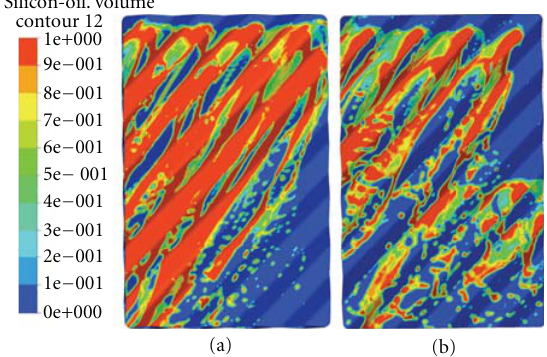
Figure 22: Wetted area on the top packing for two inlet positions. (a) Position 1. (b) Position 2. Vol. Flow rate = 811